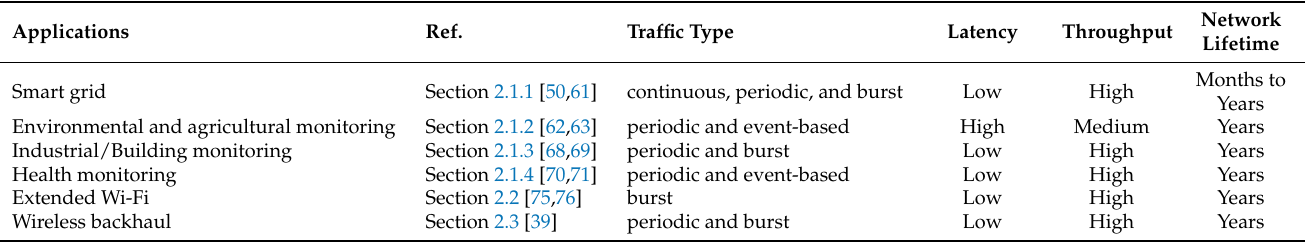
Table 3. Summary of IEEE 802.11ah-based applications under sensors and meters, extended Wi-Fi range and wireless backhaul use cases, and their requirements